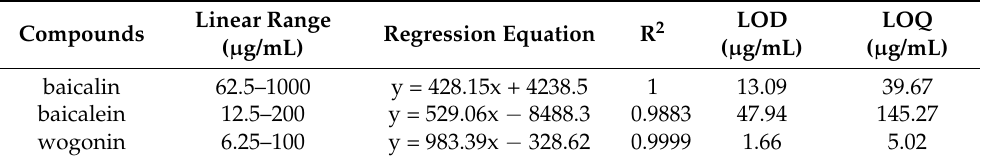
Table 2. Calibration curves, correlation coefficients, limit of detection (LOD) and limit of quantitation (LOQ) of baicalin, baicalein, and